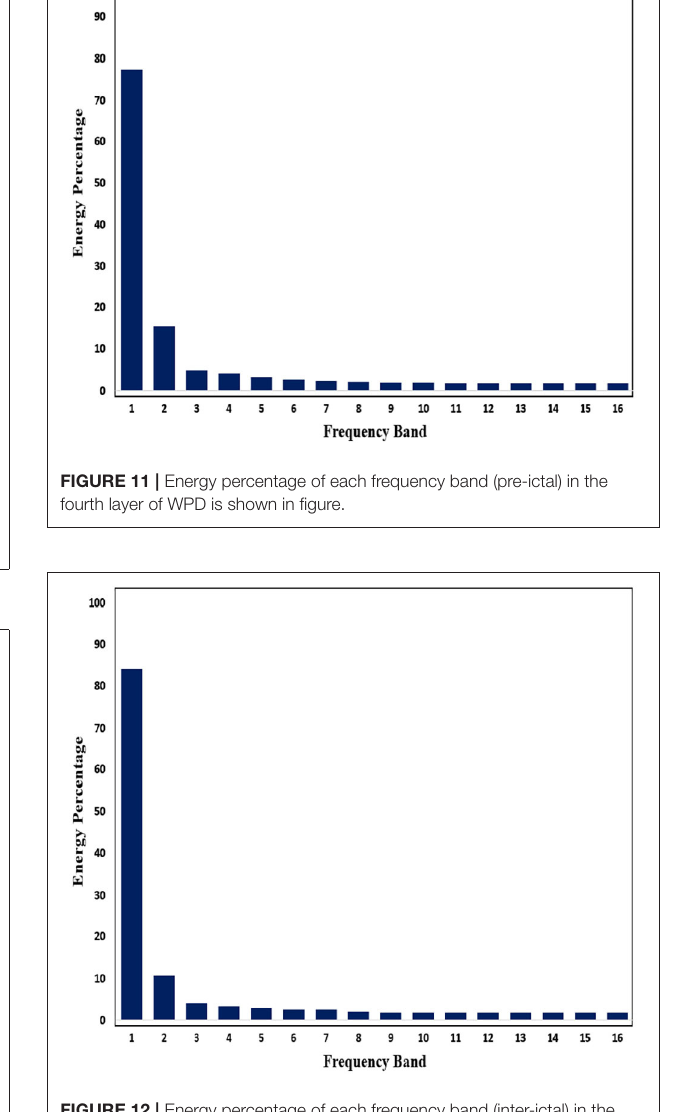
FIGURE 12 | Energy percentage of each frequency band (inter-ictal) in the fourth layer of WPD is shown in